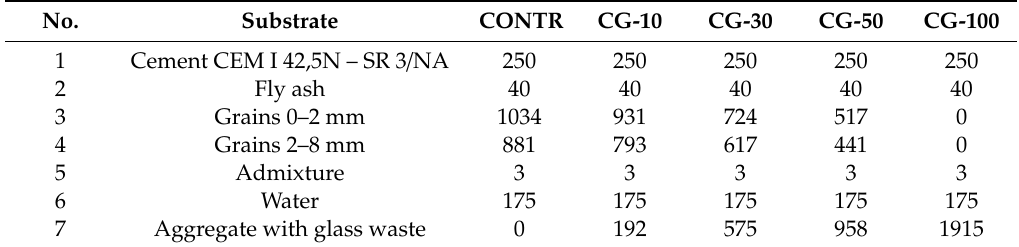
Table 6. Compositions of all prepared concrete mixtures.